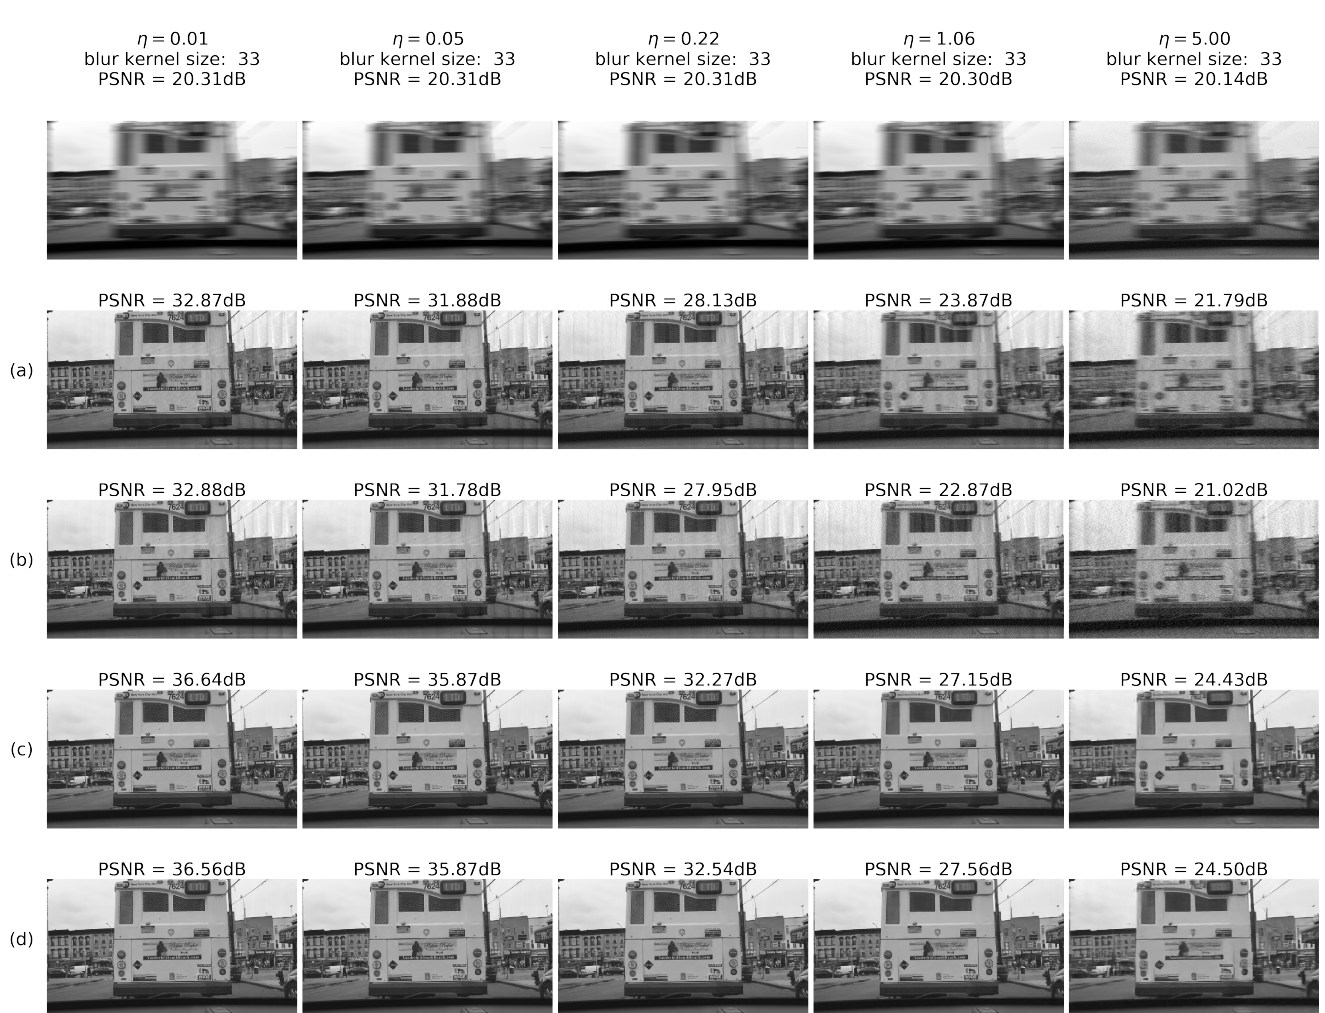
Figure 16. Deblurring using regression RegParamNet (Tikhonov): ( a ) RD output before E2E training; ( b ) RD output after E2E training; ( c ) IEN output before E2E training; ( d ) IEN output after E2E